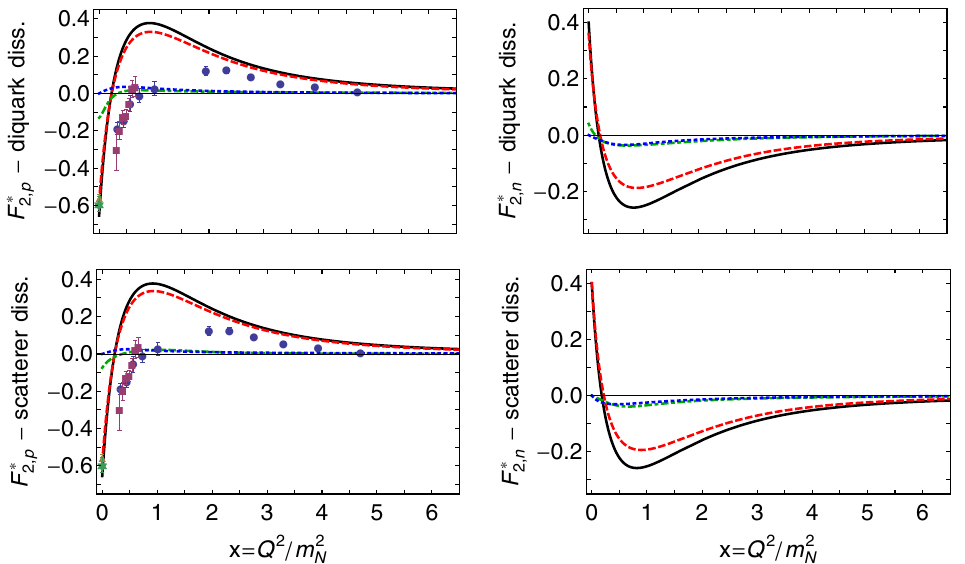
Figure 8. Computed Pauli transition form factor, F ∗ , for the charged reaction γ ∗ p → R + (left panels) and the neutral reaction 2 γ ∗ n → R 0 (right panels): solid (black) curve in each panel. Data: circles (blue) [42], squares (purple) [43, 44], triangle (gold) [47], and star (green) [48]. Upper panels – diquark breakdown: DD1 (dashed red), scalar diquark in both nucleon and Roper; DD2 (dot- dashed green), pseudovector diquark in both nucleon and Roper; DD3 (dotted blue), scalar diquark in nucleon, pseudovector diquark in Roper, and vice versa. Lower panels – scatterer breakdown: DS1 (red dashed), photon strikes an uncorrelated dressed quark; DS2 (dot- dashed green), photon strikes a diquark; and DS3 (dotted blue), diquark breakup contributions, including photon striking exchanged